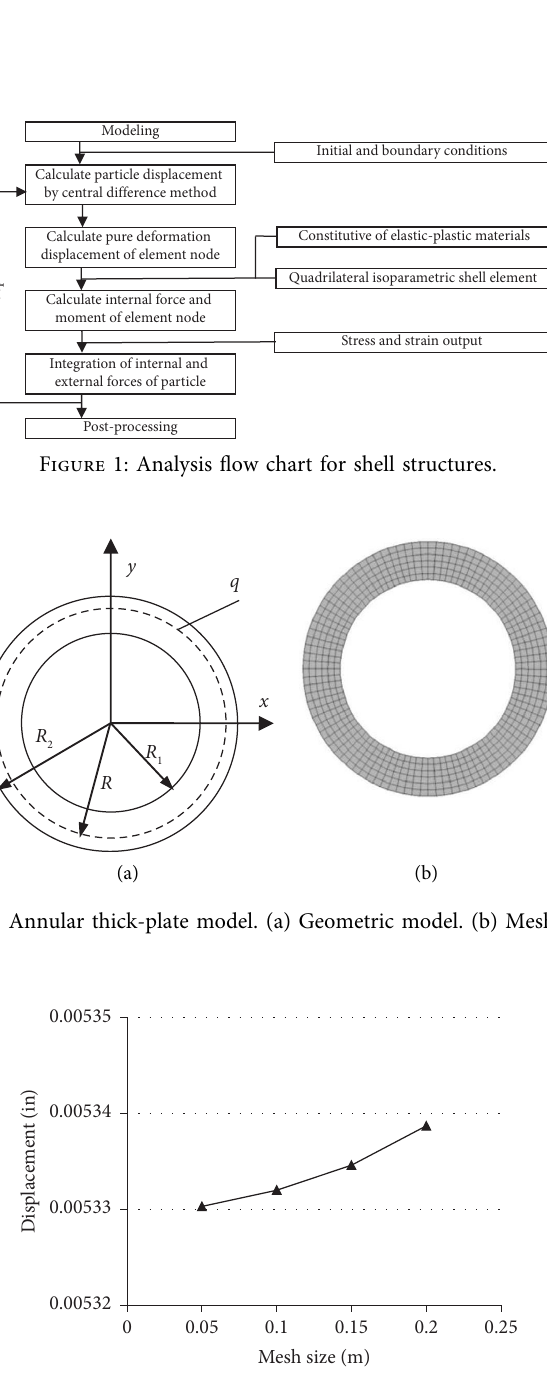
Figure 3: Comparison of vertical displacements of outer-edge nodes with diferent mesh sizes ( t